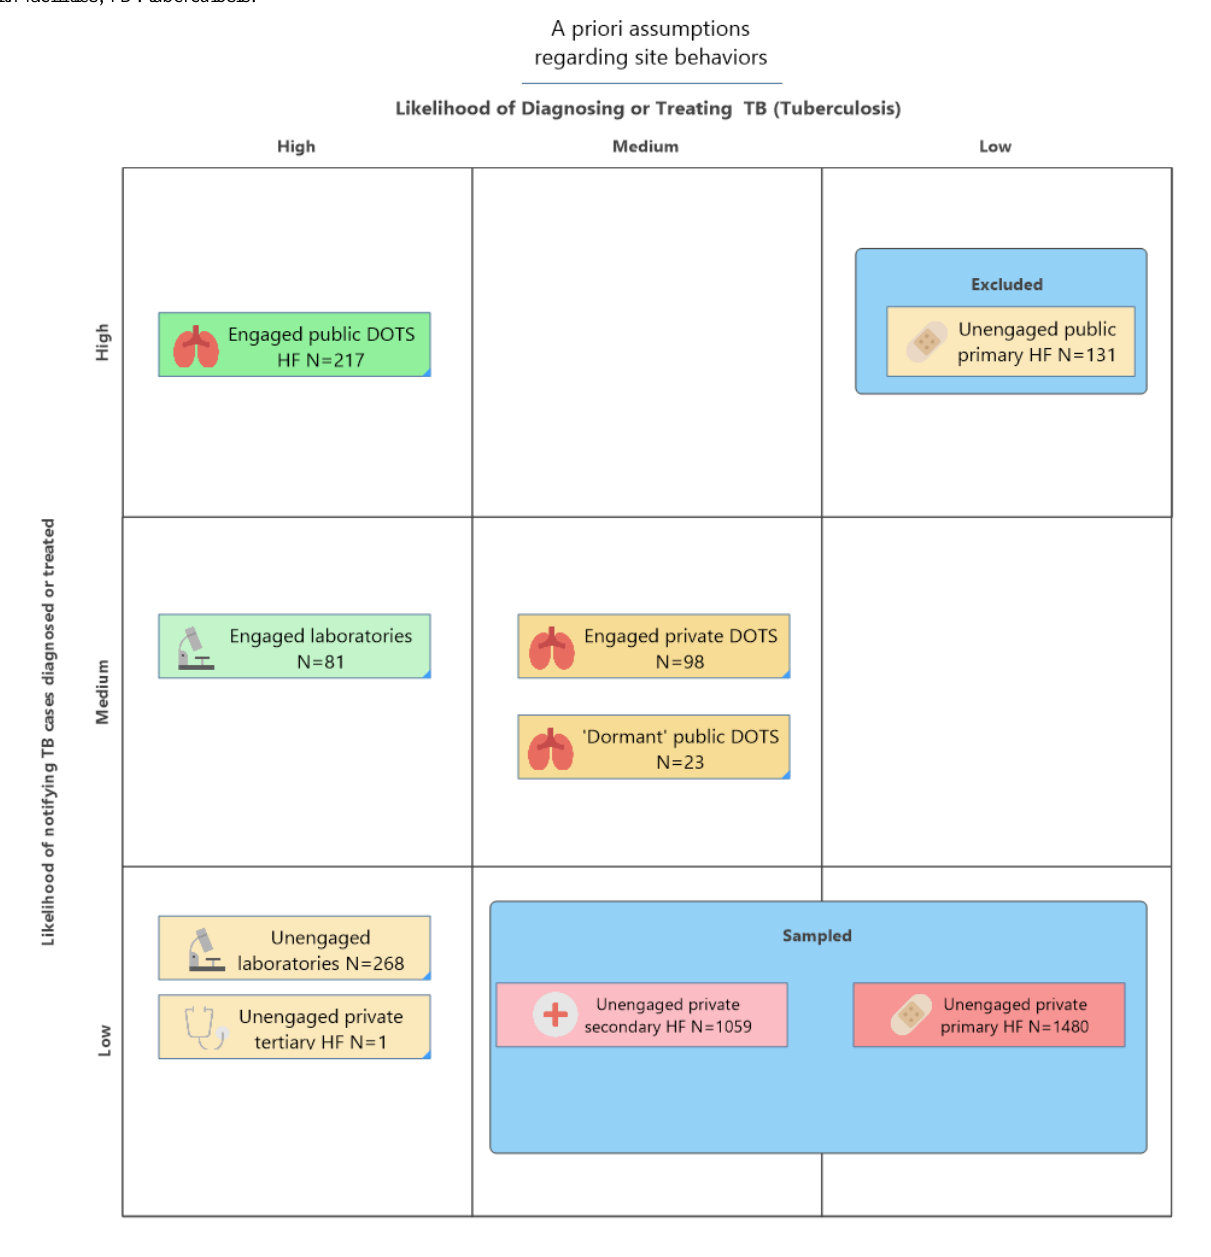
Figure 3. Behavioral assumptions driving the decision to census or sample health facility strata. DOTS: directly observed therapy short-course; HF: health facilities; TB: